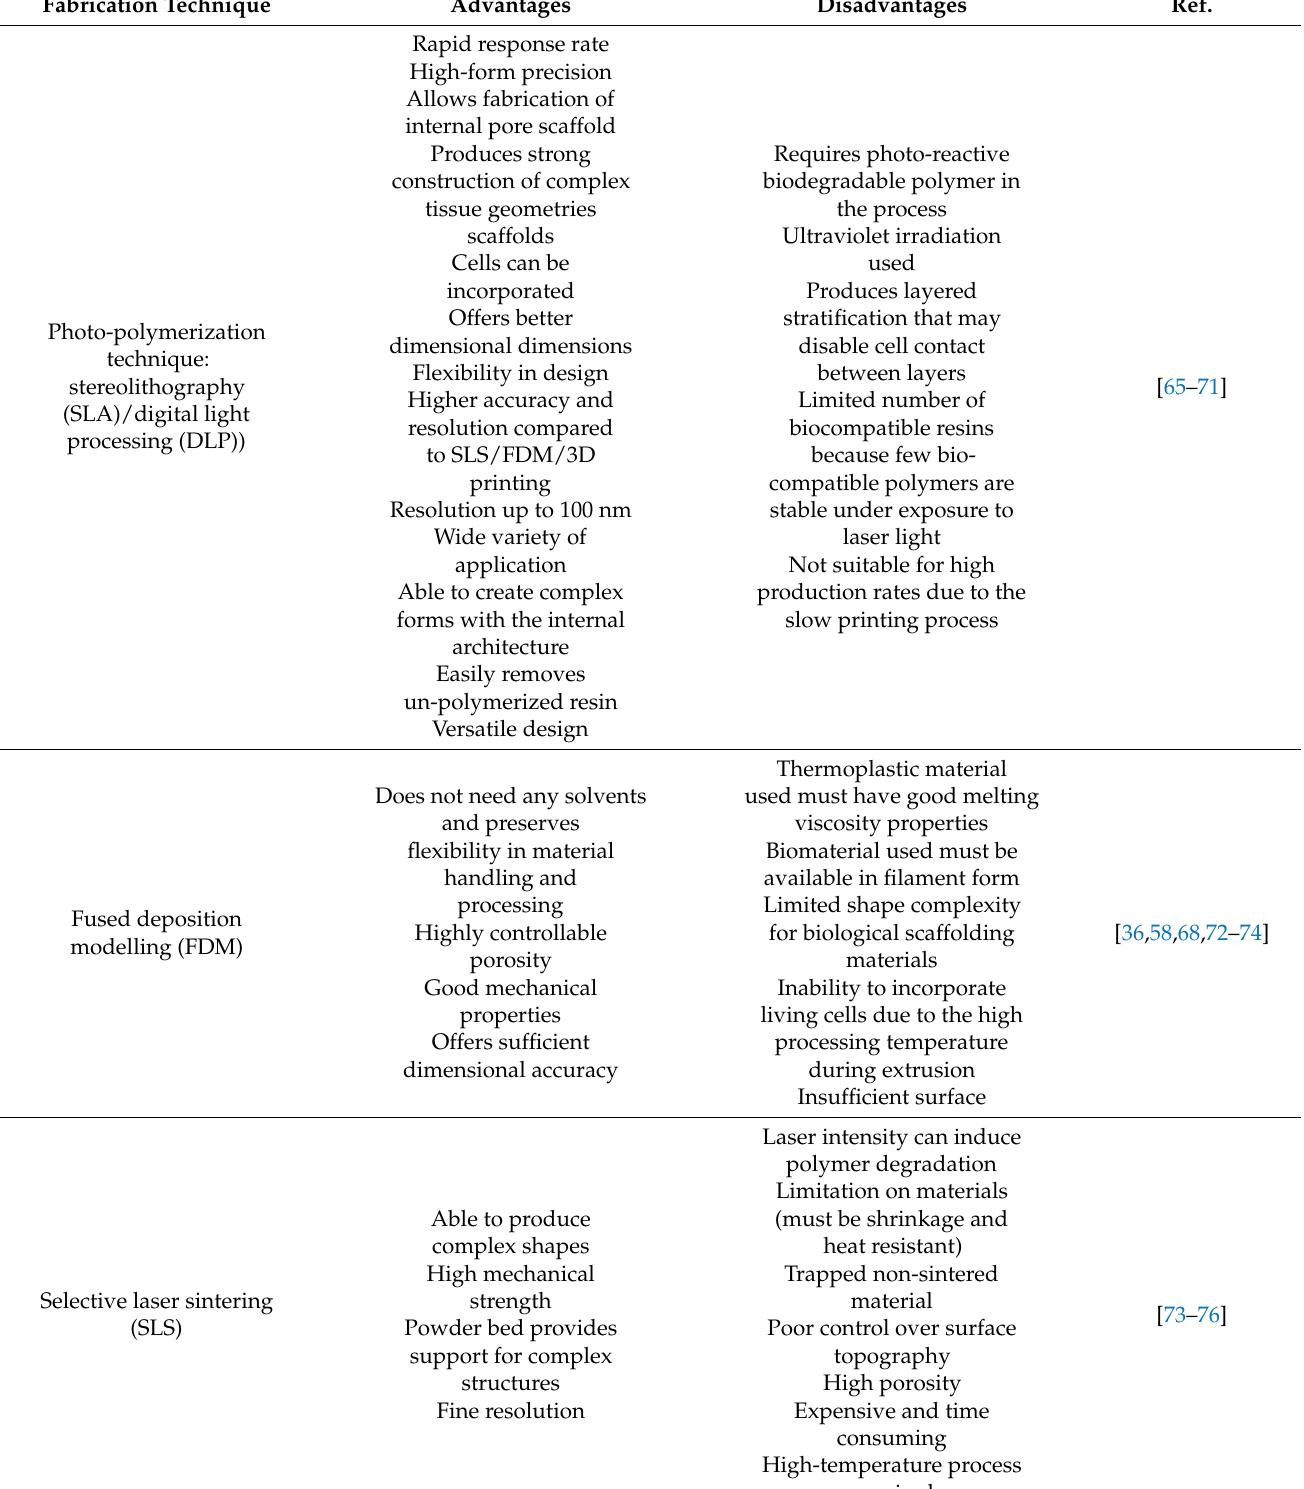
Table 2. Typical advanced manufacturing process for 3D tissue engineering scaffolds.